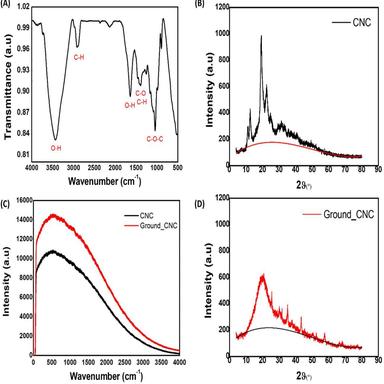
FTIR spectra (A), X-ray diffraction (B, D), Raman spectra (C) of pristine and ground structures of CNC.